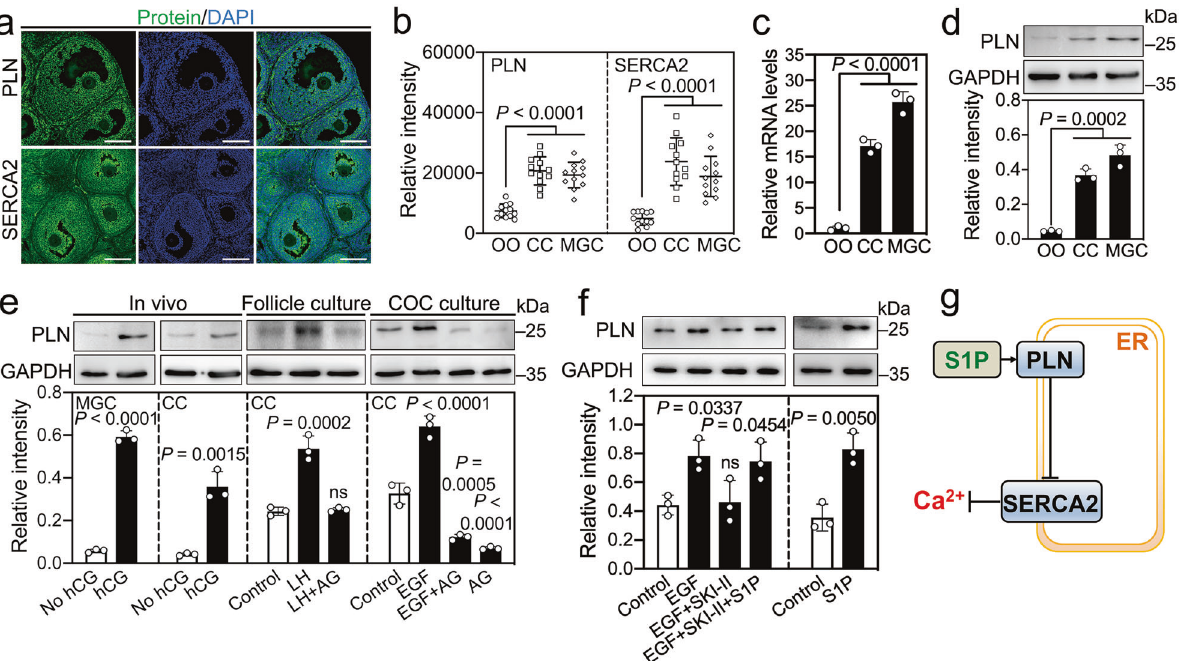
Fig. 3 LH-EGFR signaling and S1P increase the protein levels of PLN. a Representative images of PLN and SERCA2 (green) staining in the ovaries isolated from eCG-primed mice. The nuclei were counterstained with DAPI (blue). Scale bars, 100 μ m. b Fluorescence intensity analysis of PLN and SERCA2 in oocytes (OO), cumulus cells (CC), and MGCs. A total of 12 large antral follicles were scored. c , d The mRNA ( b ) and protein ( c ) levels of PLN in oocytes, cumulus cells, and MGCs isolated from eCG-primed mice. e Western blotting analysis of PLN levels in MGCs and/or cumulus cells isolated from the mice before and after hCG treatment (2 h), the follicles at 2 h of culture, and the COCs at 2 h of culture. f Western blotting analysis of PLN levels in cumulus cells of COCs at 2 h (right panel) or 0.5 h (left panel) of culture. GAPDH was used as an internal control ( d – f ). g Model of the signaling pathway for S1P elevating intracellular calcium levels. The endoplasmic reticulum (ER) is represented as an orange square. S1P increases PLN levels to inhibit SERCA2 activity, thereby increasing the intracellular Ca 2 + concentration. For a – f , n = 3 independent experiments. The data represent the mean ± s.d. P values were determined by two-sided Student ’ s t -test (left two panels of e , right panel of f ) and one-way ANOVA followed by Tukey ’ s test ( b – d , right two panels of e , left panel of f ). ns not signi fi (Fig. S11). Next, we assessed the effect of S1P treatment during in vitro maturation (IVM) on embryonic development after in vitro fertilization (IVF). Both the two-cell rate and the blastocyst rate were signi fi cantly increased when wild-type COCs were matured